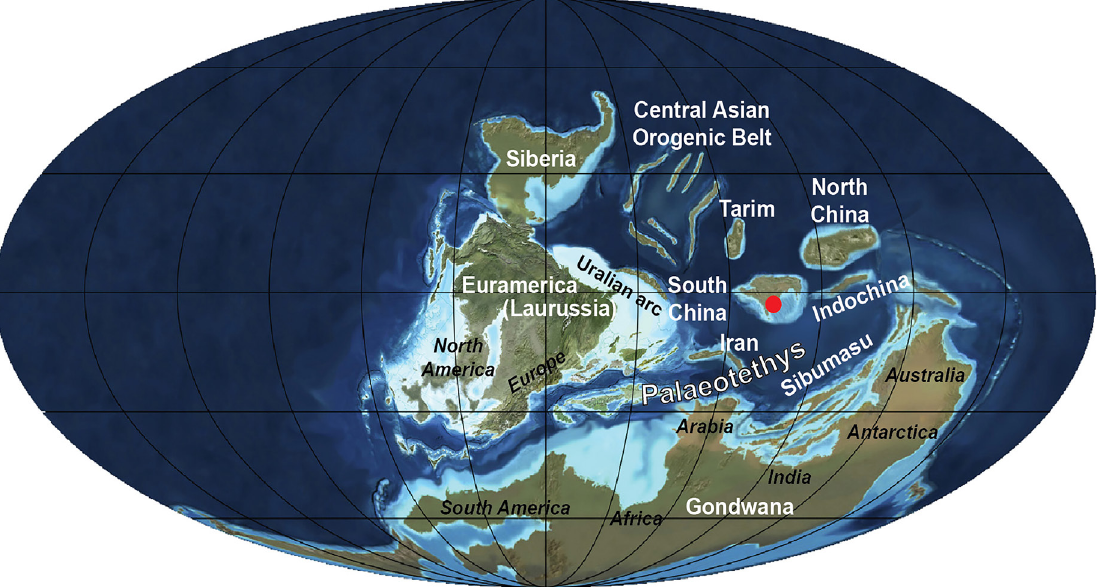
Fig. 1. Palaeogeographic map with the rough location of the Blue Snake section (red spot) during the late Devonian (modified from Carmichael et al.